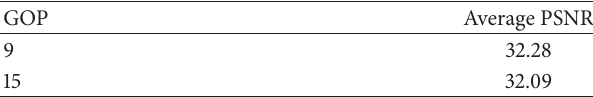
Table 3: The simulation results of the average PSNR value.